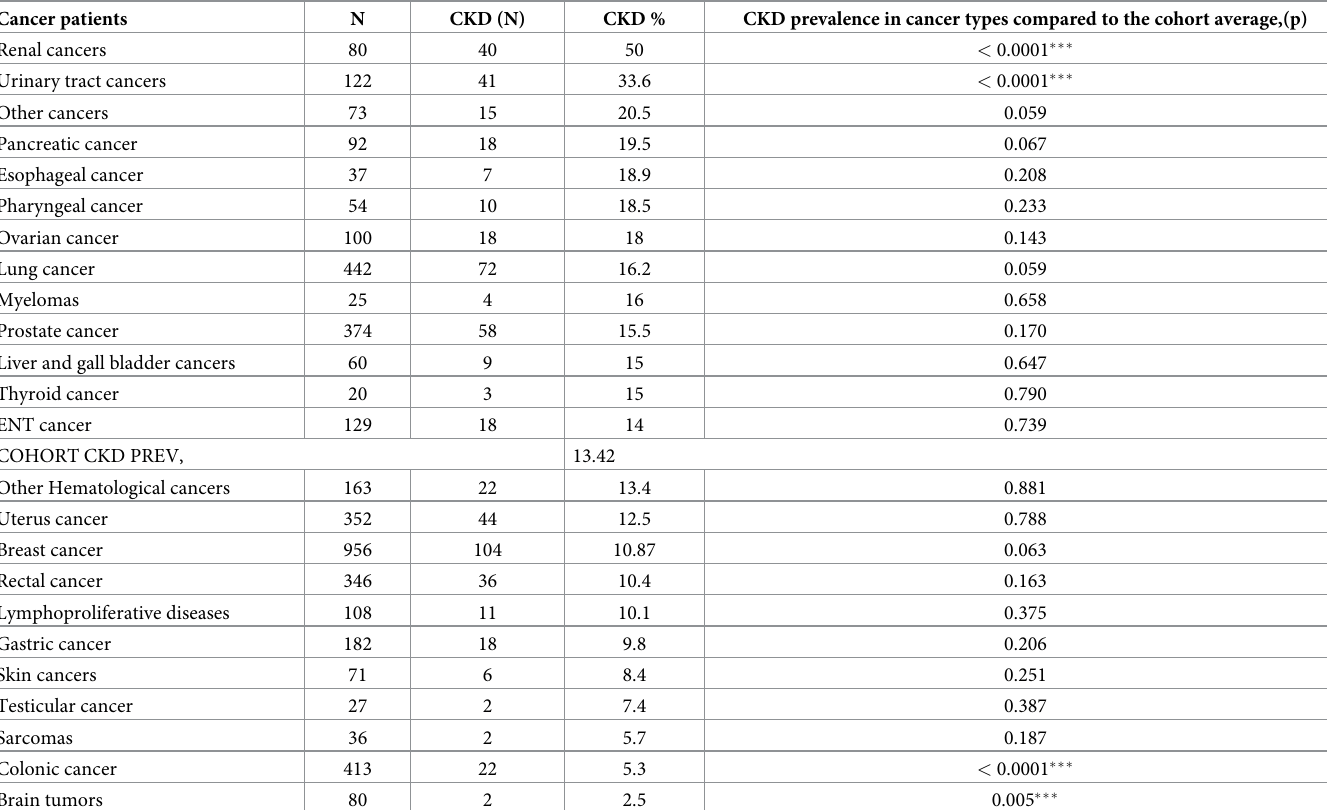
Table 3. Prevalence of CKD in different cancer types. Cancer